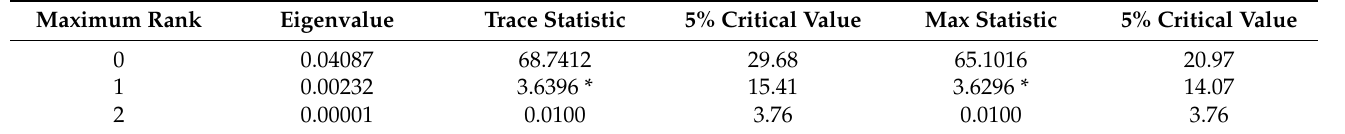
Table 1. The Johansen test of cointegration. Electricity price: PUN.